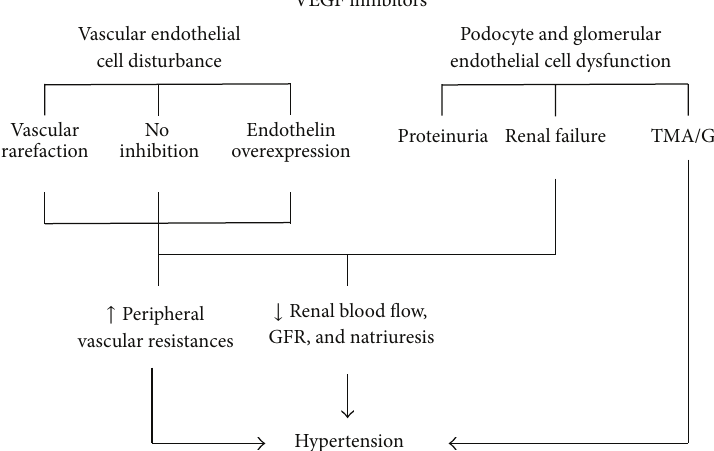
Figure 1: Potential mechanisms of hypertension related to anti-VEGF